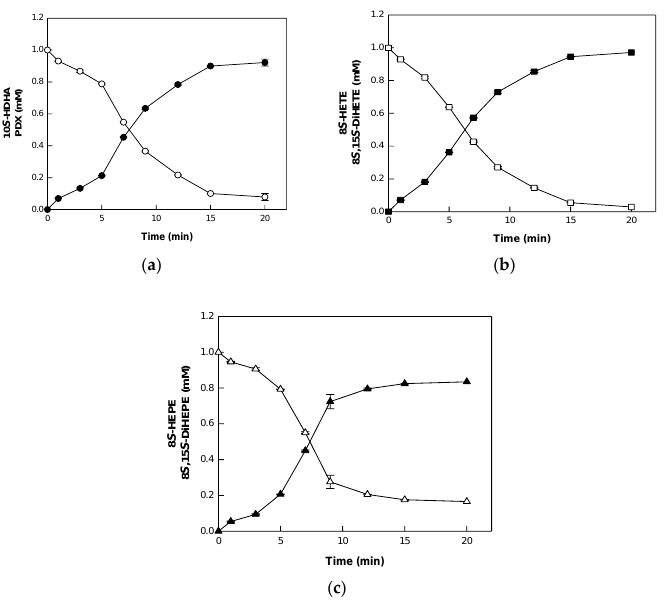
Figure 3. Biotransformation of HFAs to DiFHAs by BT 15SLOX. ( a ) Biotransformation of 10S-HDHA (empty circle) into PDX (filled circle). ( b ) Biotransformation of 8S-HETE (empty square) to 8S,15S- DiHETE (filled square). ( c ) Biotransformation of 8S-HEPE (empty up-triangle) to 8S,15S-DiHEPE (filled up-triangle). The reactions were performed with BT 15SLOX (1.5 mg/mL), each substrate (7 mM), and cysteine (10 mM) in 50 mM HEPES buffer (pH 7.5) at 30 °C for 20 min. Data represent the means of three experiments, and error bars represent the standard deviations.